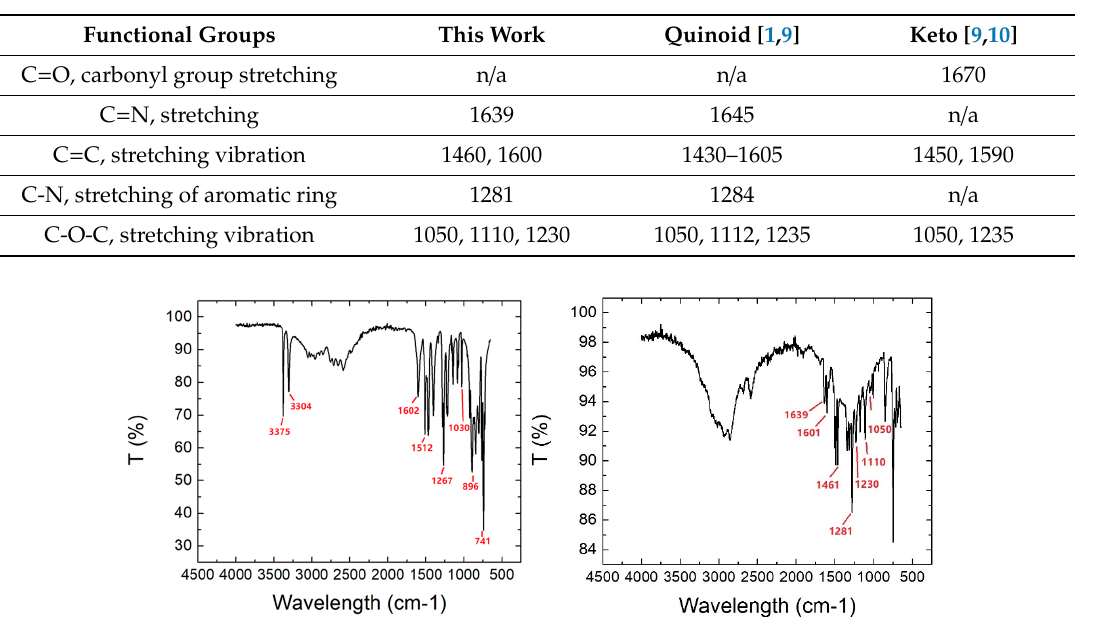
Figure 3. FTIR spectrum of oAP before ( left ) and after ( right ) the plasma treatment.